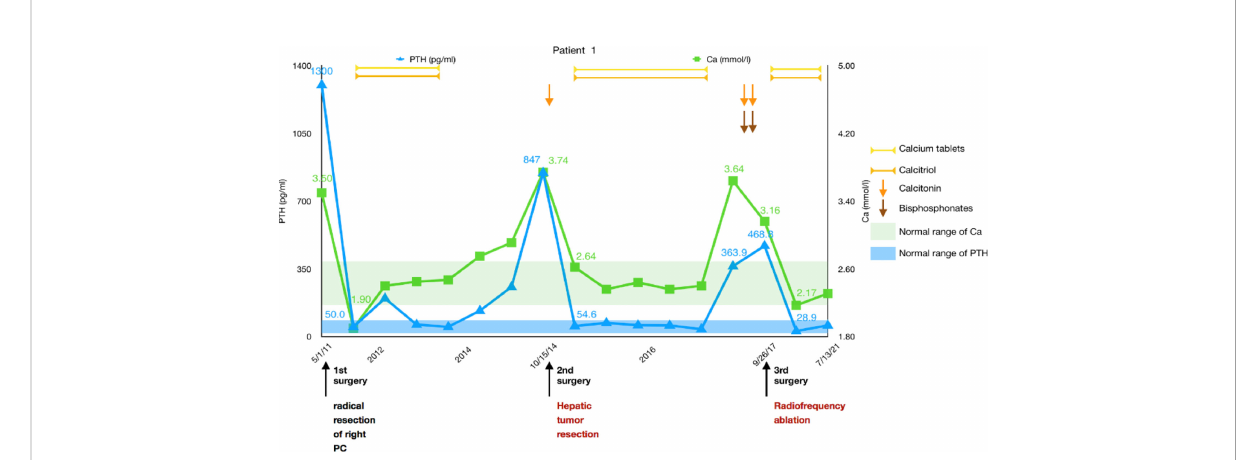
FIGURE 1 Summary of the clinical course, including changes in serum calcium and PTH of patient